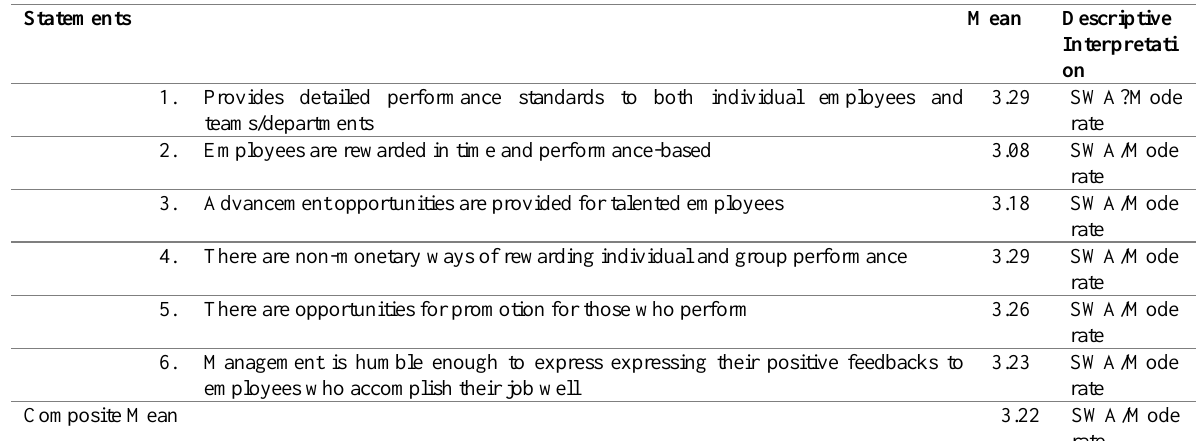
Table 5: Organizational Climate Along with Rewards &